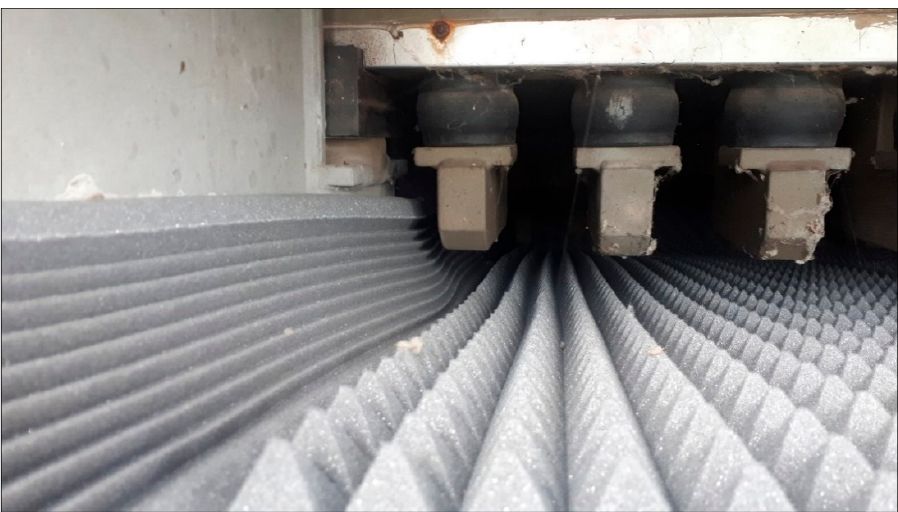
Figure 9. View of the sound absorbing materials from the inside of the sound cover (left side—the “bass trap”, right side—the “pyramid”.